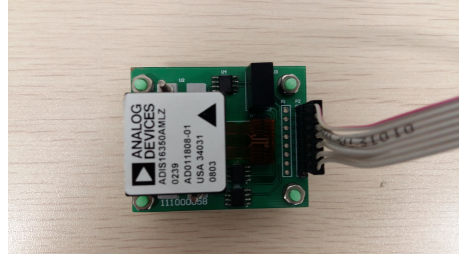
Figure 5. Tri-Axis inertial sensor.